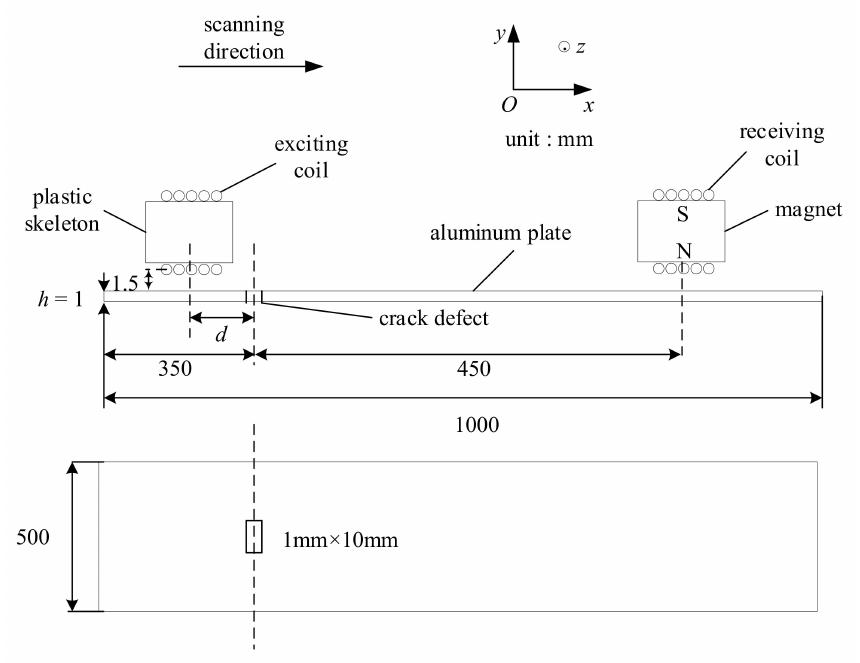
Figure 6. The geometry of sample and system in scanning